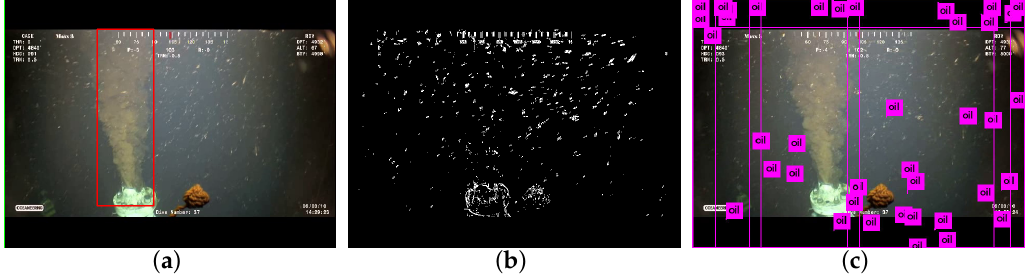
Figure 7. Results comparison: ( a ) ours; ( b ) frame difference [8]; and ( c ) yolov3